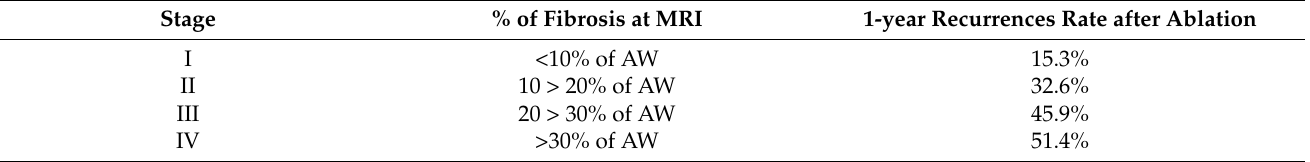
Table 1. Utah stage classification of left atrial fibrosis with cardiac MRI and correlation with outcomes after atrial fibrillation ablation in the DECAAF